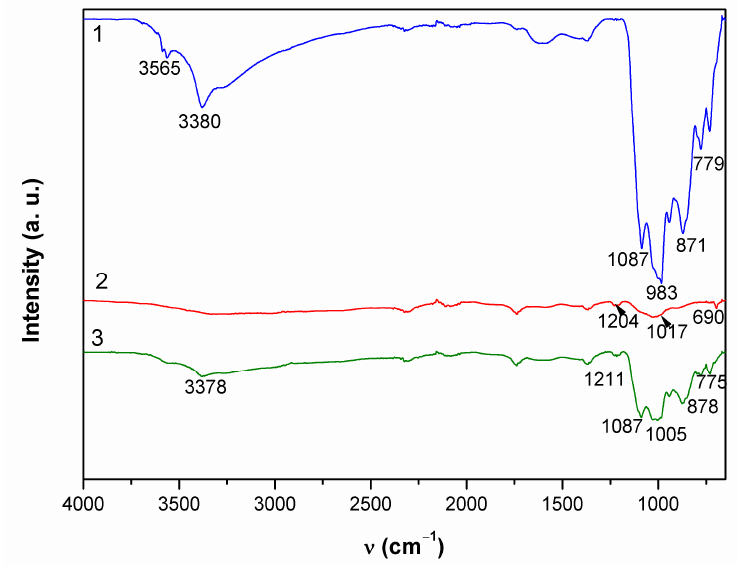
Figure 8. ATR-FTIR spectra collected on patina samples from MC.